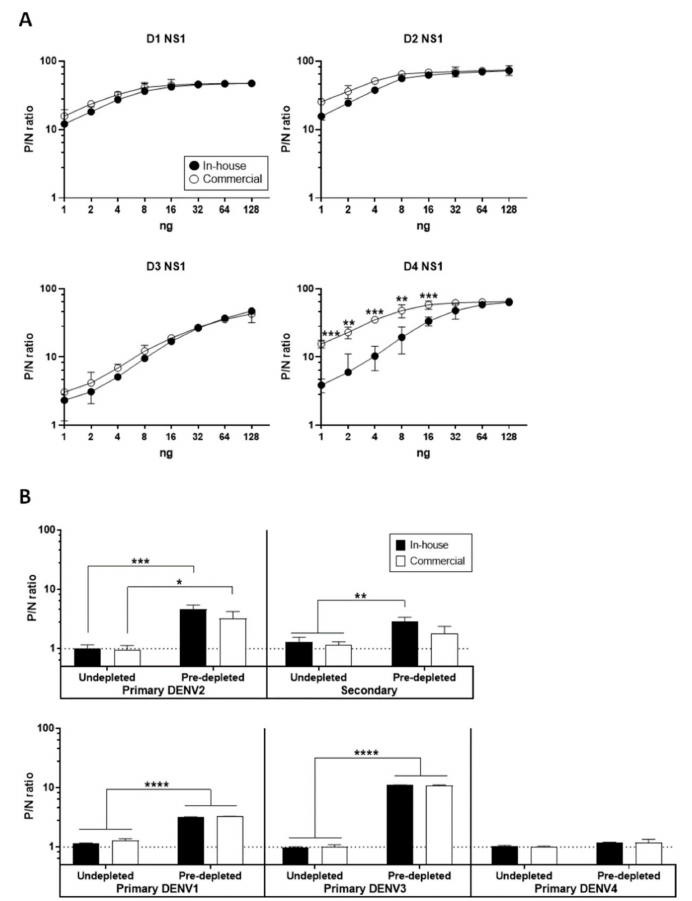
Figure 2. Antigenicity of in-house-produced and commercial DENV NS1 proteins. ( A ) Both in-house- produced and commercial D1 to 4 NS1 antigens were titrated at varying amounts in an Ag–ELISA and detected with serotype-specific murine hyperimmune sera to compare the antigenicity of proteins from different sources. ( B ) NS1 immunoglobulin G-antibody capture enzyme-linked immunosorbent assay (GAC–ELISA) showing similar antigenicity of both in-house-produced and commercial NS1 antigens using four sera with primary DENV1 to 4 infections and one with secondary infection. NS1 GAC–ELISA was performed with or without predepletion of serum anti-premembrane/envelope (prM/E) antibodies using a combination of DENV serotypes 2 + 3 virus-like particle (VLP) antigens. The dotted line indicates the positive-to-negative (P/N) ratio of negative control serum. All data were obtained from three independent experiments with duplicates, and the standard deviations are indicated by error bars. Means were analyzed by one-way analysis of variance (ANOVA) and statistical significance is indicated with asterisk (* p < 0.05; ** p < 0.01; *** p < 0.001; **** p <